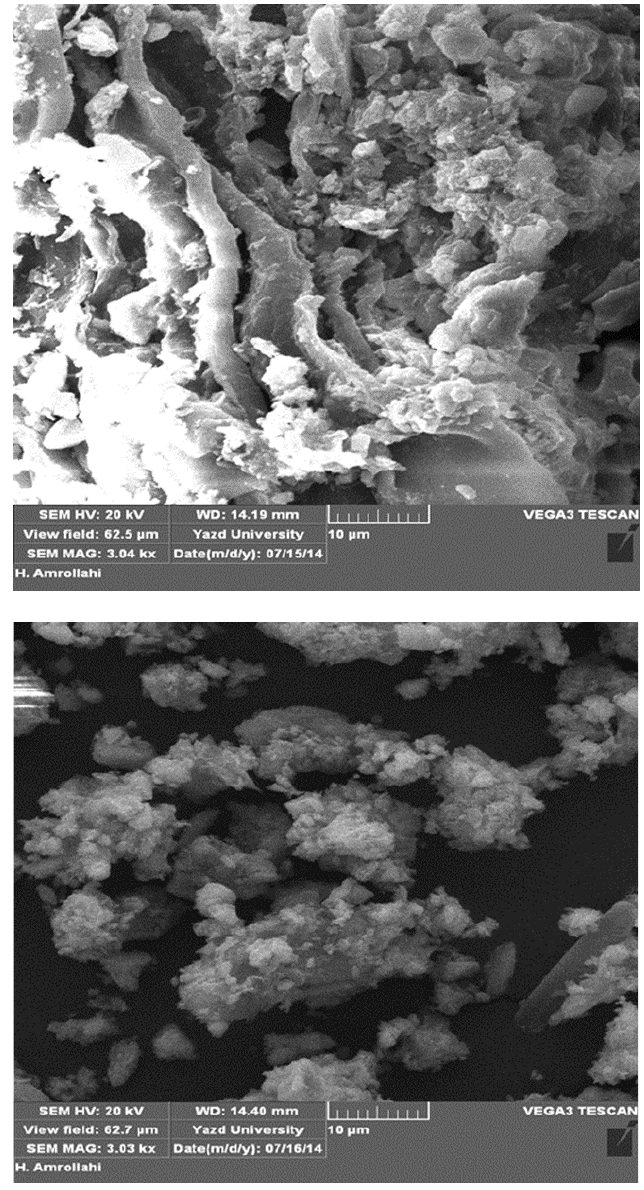
Figure 7. Scanning electron micrographs of (above) the untreated peat (from Rahgozar & Saberian 2015), and (below) the peat stabilised with 10 % shredded tyre chips and sand (no tyre chips in SEM